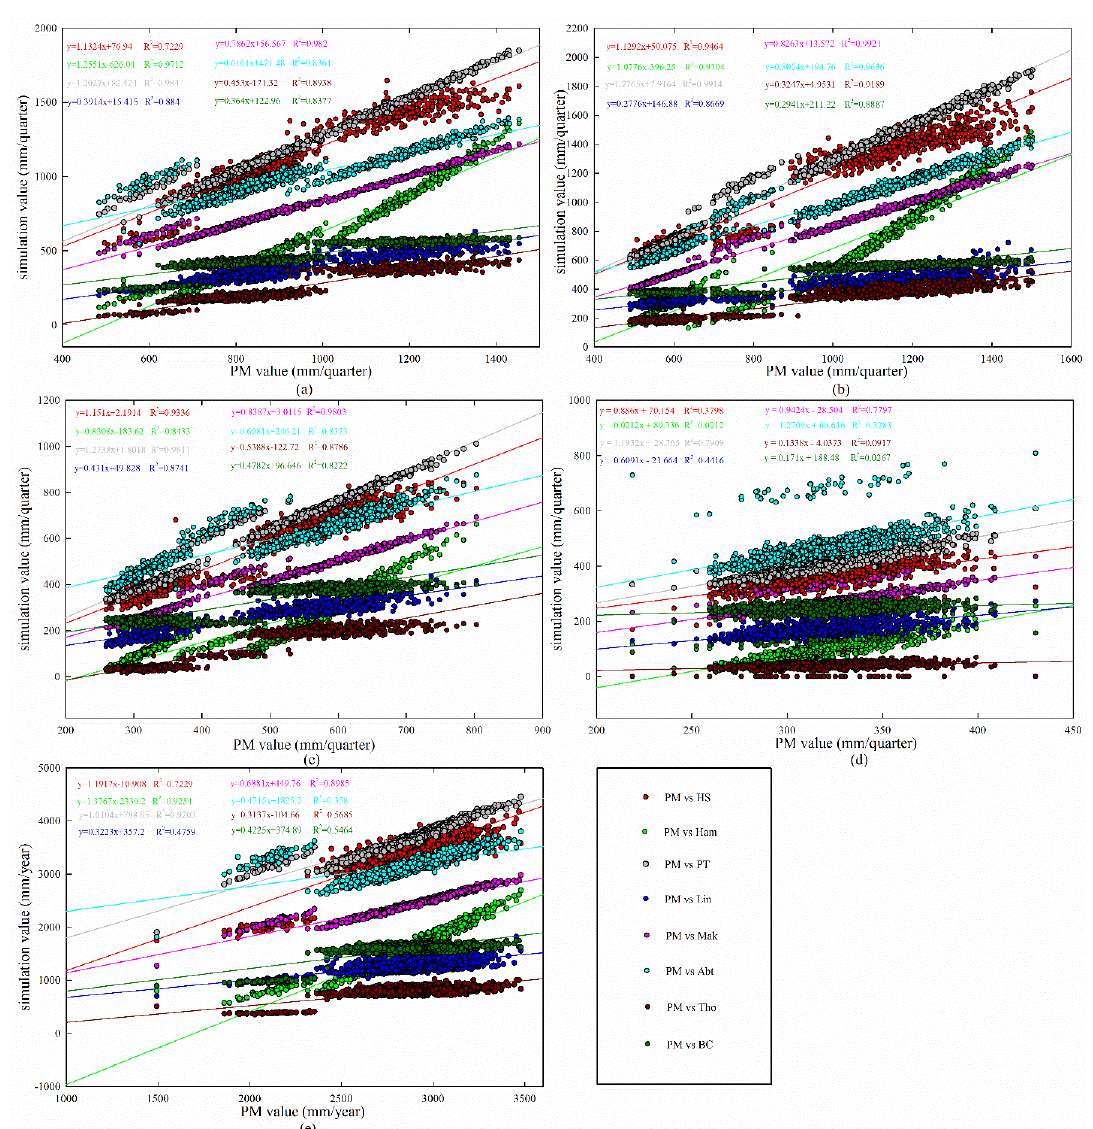
Figure 2. Linear regression of measured and simulation values in Sichuan basin: ( a ) spring; ( b ) summer; ( c ) autumn; ( d ) winter; and ( e ) annual.